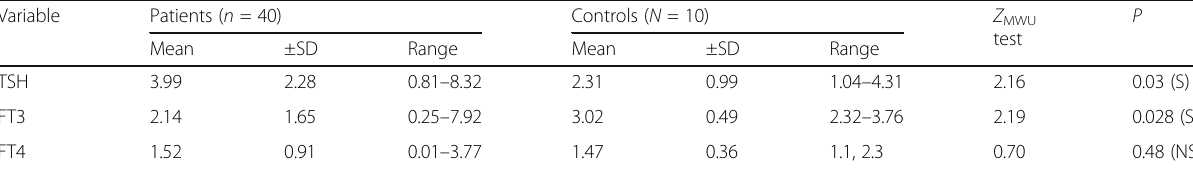
Table 4 Comparing the studied groups regarding thyroid function tests Variable Patients ( n = 40)